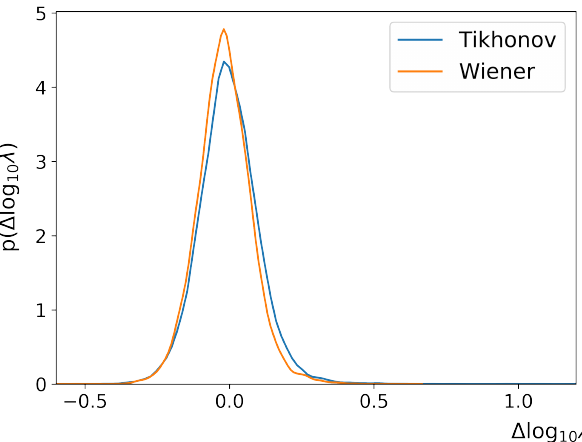
Figure 11. Direct λ opt regression